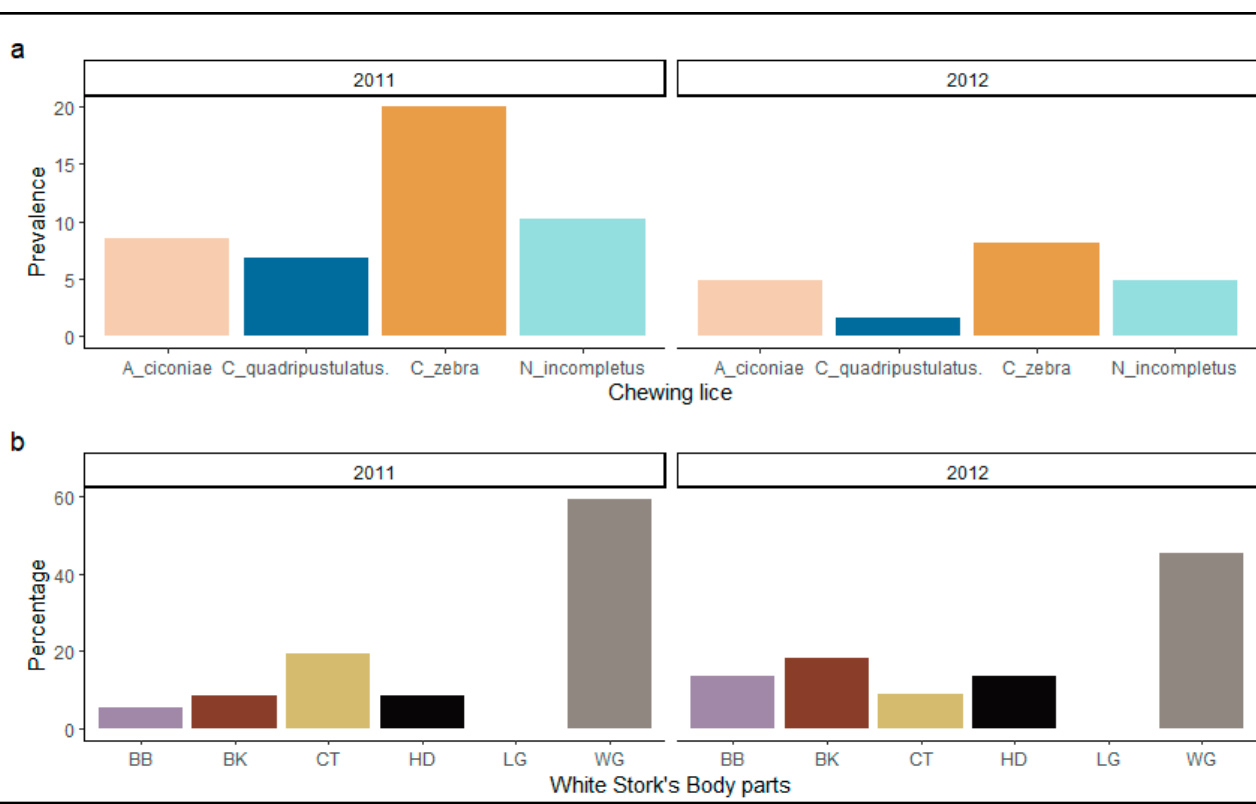
Figure 2. Temporal variation in prevalence of lice at the Dréan colony ( a ). Percentage of lice on the following different body regions of white stork nestlings: BB, breast and belly; BK, back; CT, crissum and tail; HD, head; LG, legs; WG, wings in 2011 and 2012 ( b ).